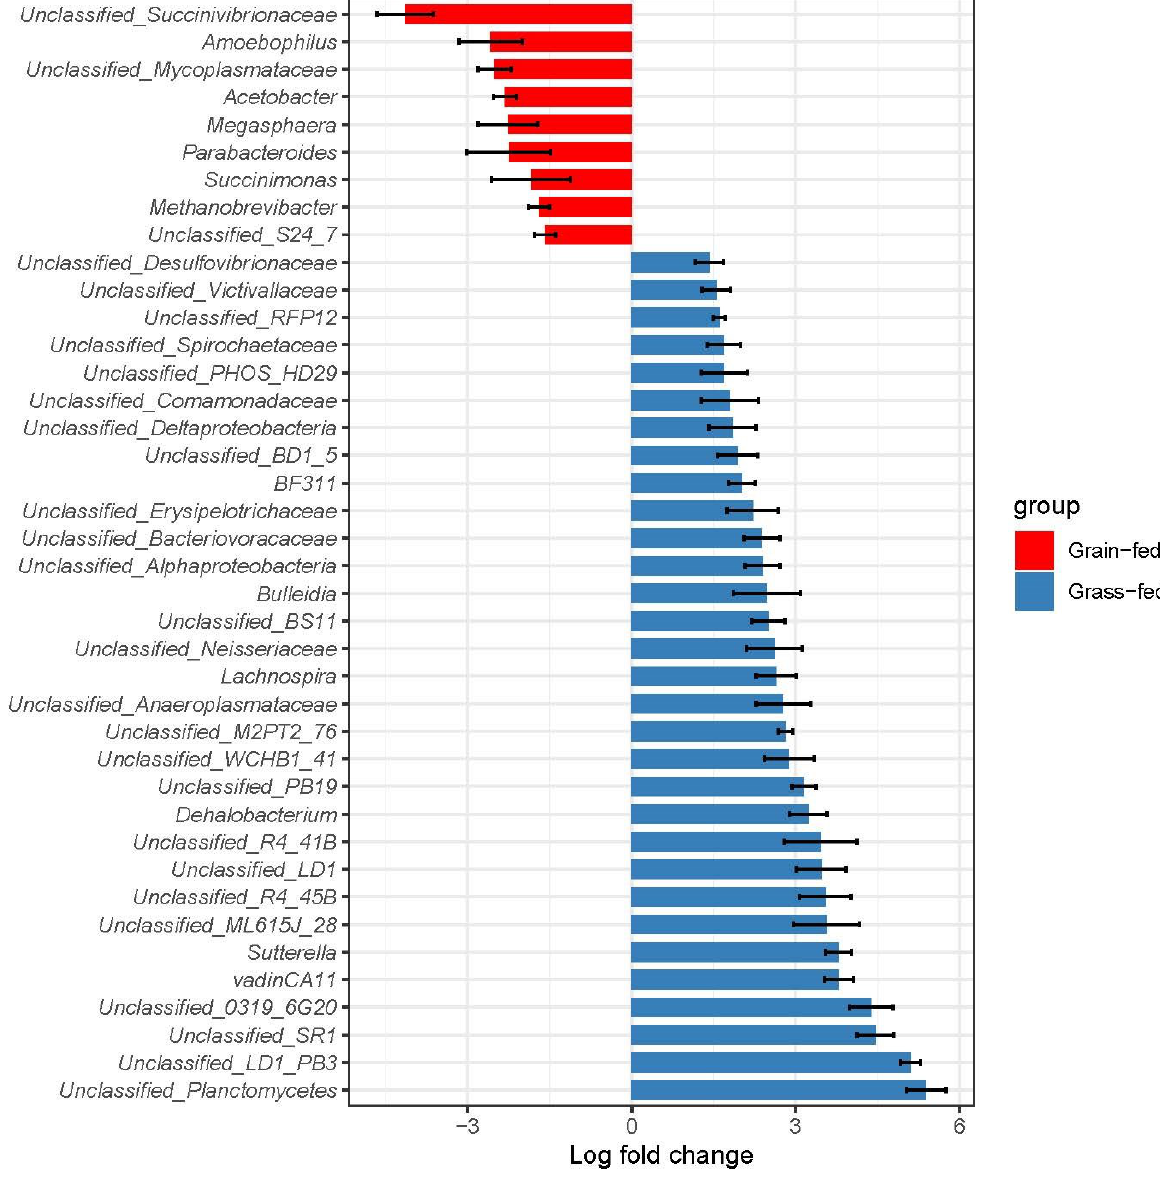
Figure 4. Genera that were significantly different in abundance between the grass-fed and grain-fed rumen microbiome. The x axis denotes the log fold change of the abundances for each taxon in grass-fed group over grain-fed